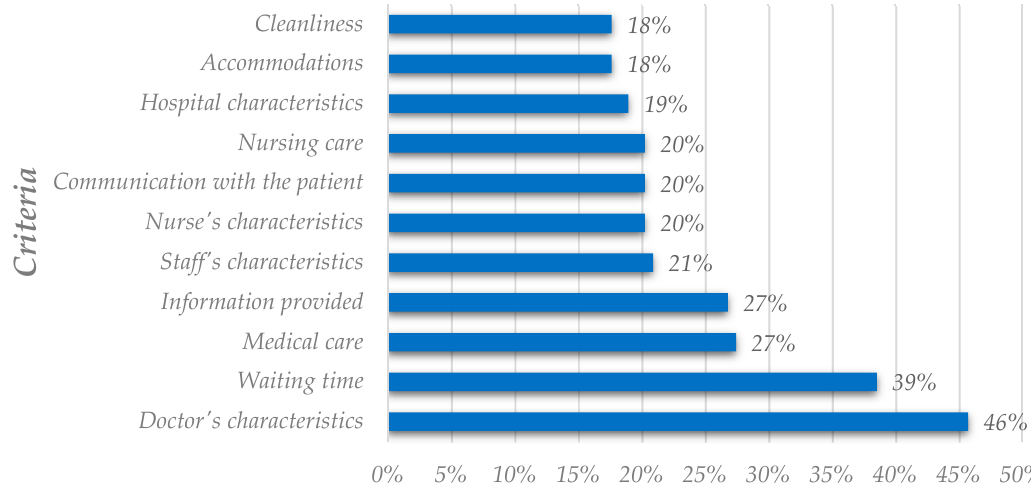
Figure 2. Analysis of the most utilized criteria in the literature (global analysis).